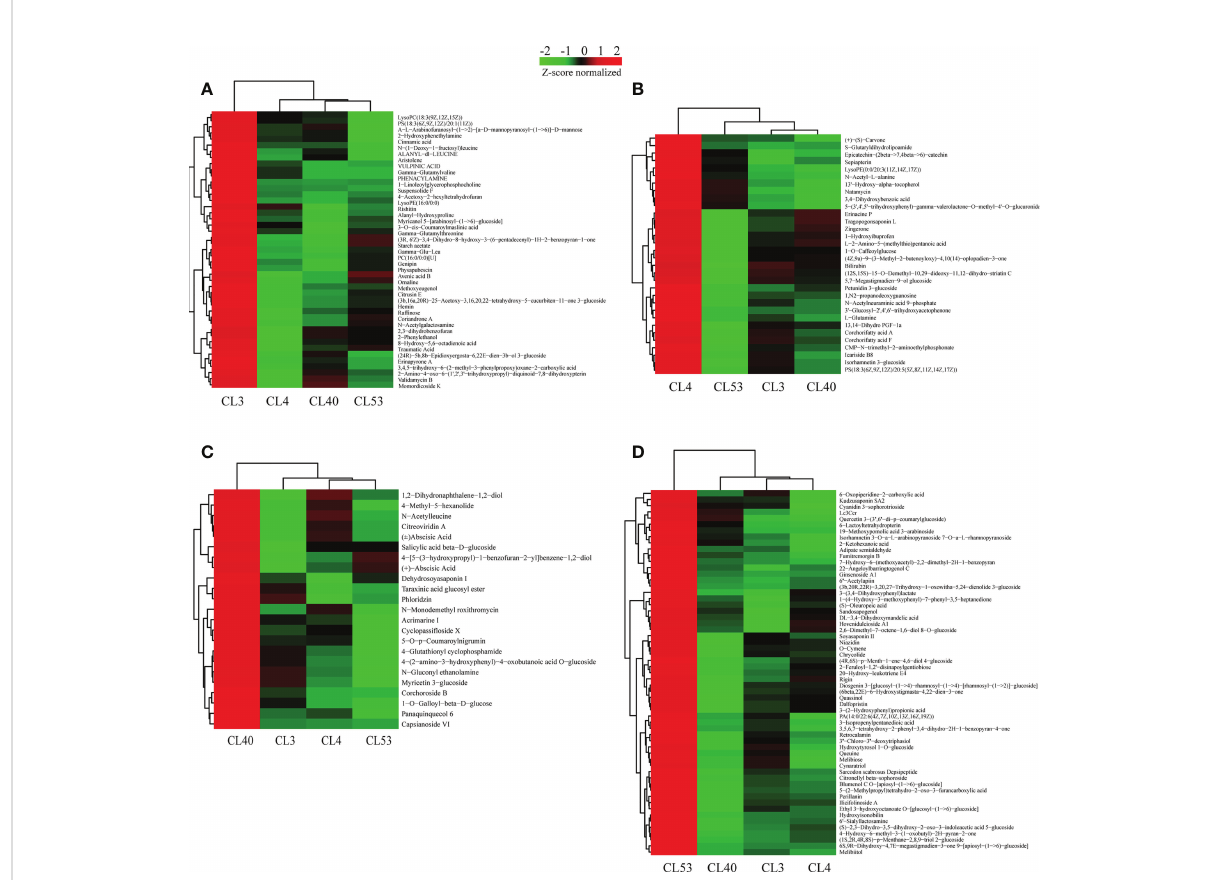
FIGURE 5 Relatively highly expreessed metabolites identi fi ed at a speci fi c varieties. (A) Heatmap displaying the special expression meabolites in samples of CL3. (B) Heatmap displaying the special expression metabolites in samples of CL4. (C) Heatmap displaying the special expression meabolites in samples of CL40. (D) Heatmap displaying the special expression meabolites in samples of